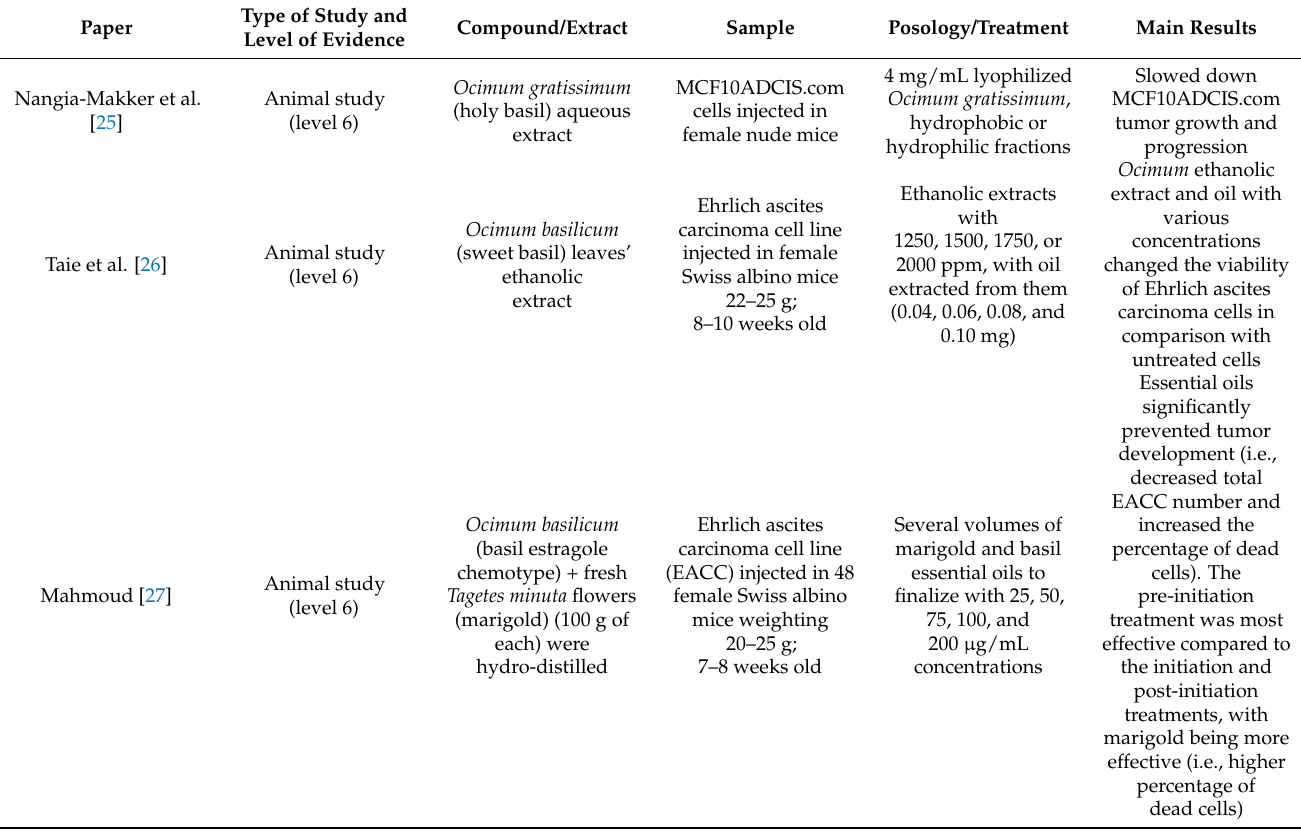
Table 1. Anticarcinogenic effects of basil extracts in animal